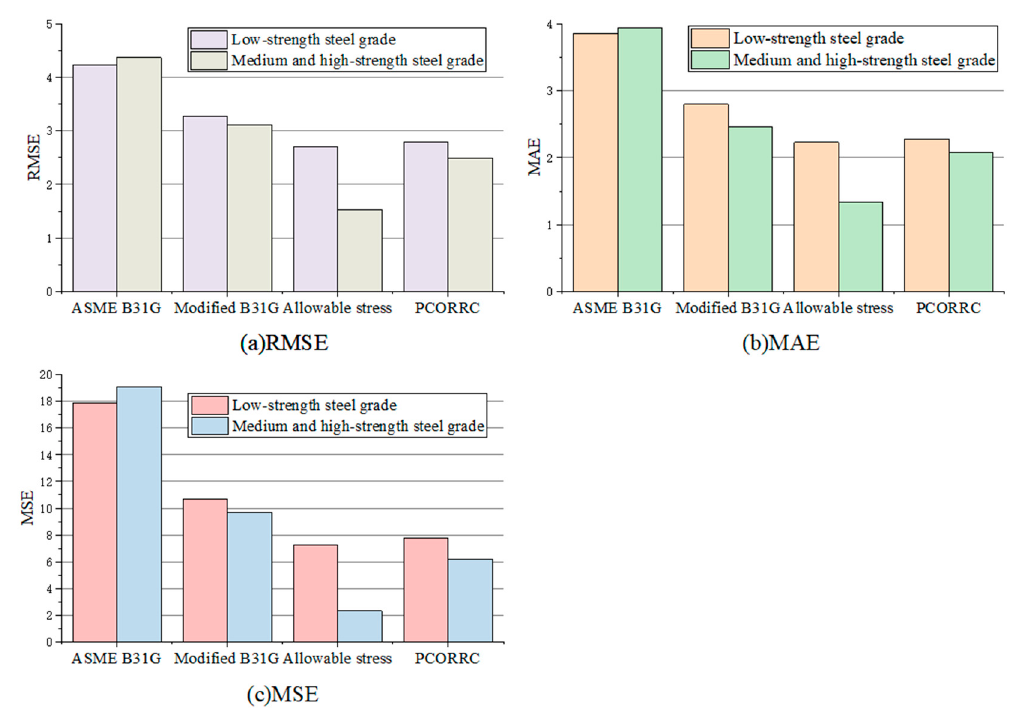
Figure 9. Errors in calculating failure pressure of corroded pipelines of low, medium, and high strength steel grades by different methods: ( a ) RMSE; ( b ) MAE; ( c ) MSE.